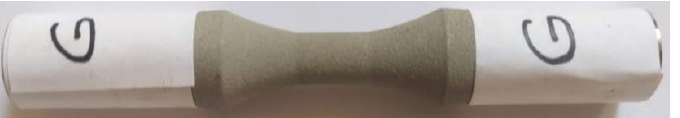
Figure 10. Sample G—unbroken after over 5 million cycles. σ = 318 MPa, n = 5,000,208